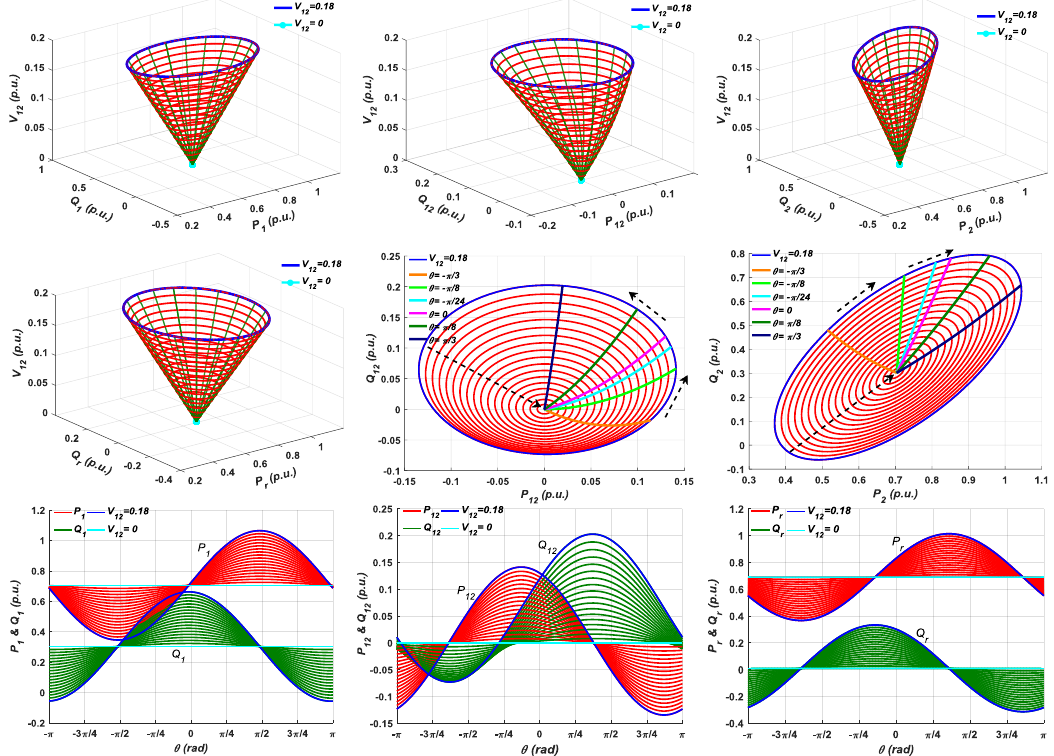
Figure 7. The power flow spatial operation surfaces and planes when V r = 0.9 , δ = – π/ 8.